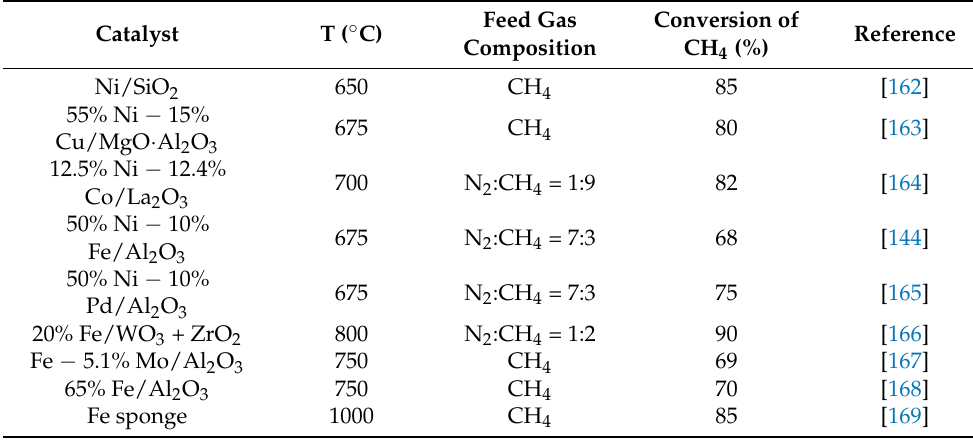
Table 2. Comparison of the catalyst activity in methane